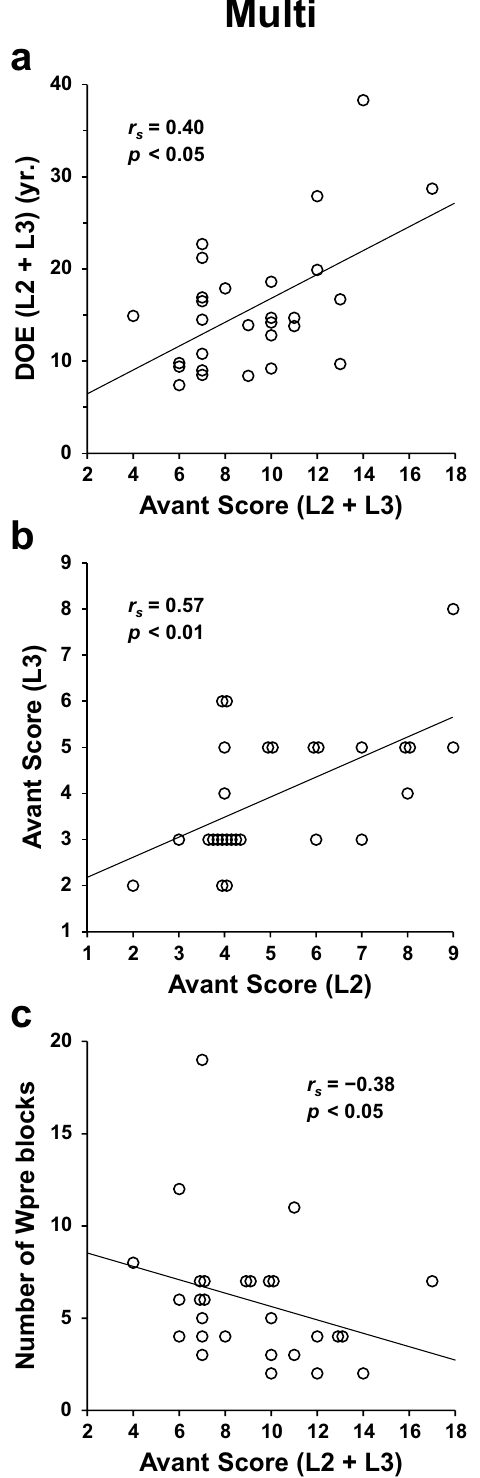
Figure 2. Consistency among multiple language abilities for the multilingual (Multi) group. ( a ) A significant correlation between the Avant scores (a standard listening proficiency test) and duration of exposure (DOE), where the scores were combined for second and third languages (L2 and L3). ( b ) Correlation between the Avant scores in L2 and L3. ( c ) The negative correlation between the combined Avant scores and number of blocks (eight trials per block) to reach the criterion for Wpre (“preparatory” task trials under the Words condition). These results indicate consistent listening abilities among multiple languages of L2, L3, and Kazakh (initial exposure). The horizontally spreading dots were expanded manually to show multiple discrete points. These images were created using Microsoft Excel 2013 (ver. 15.0.5319.1000, https:// www. micro soft. com) and Adobe Illustrator (as